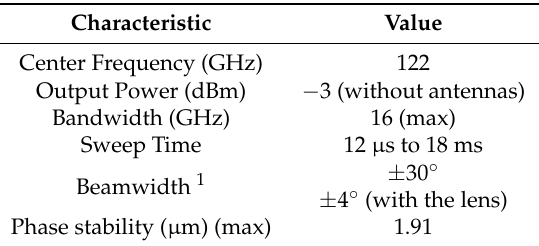
Table 3. Main characteristics of the radar module